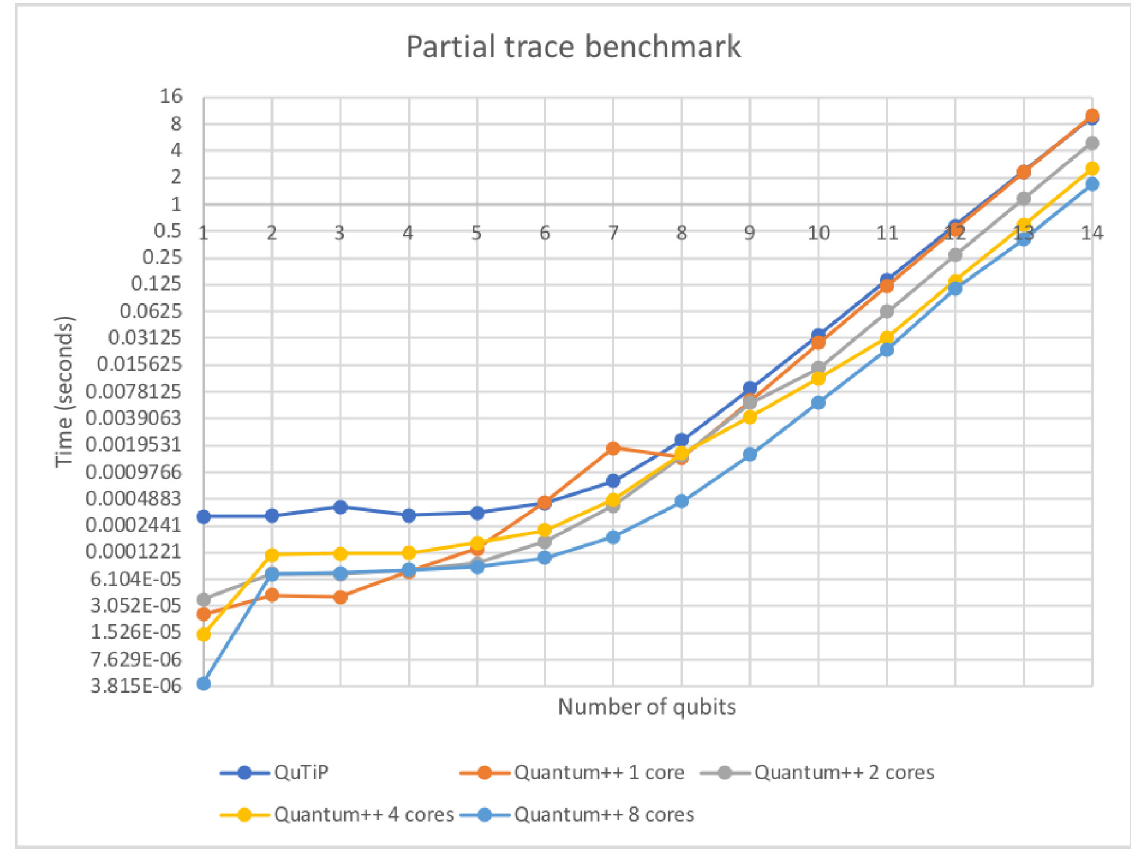
Fig 1. Partial trace on n qubits. Some minor irregularities (spikes) in the plot are most likely due to the fact that the machine we ran the experiments on is not real-time, and the operating system may have performed job scheduling during that time. Note that the single core version of Quantum++ over-performs QuTiP. Remark also that Quantum++ scales well with the number of CPU